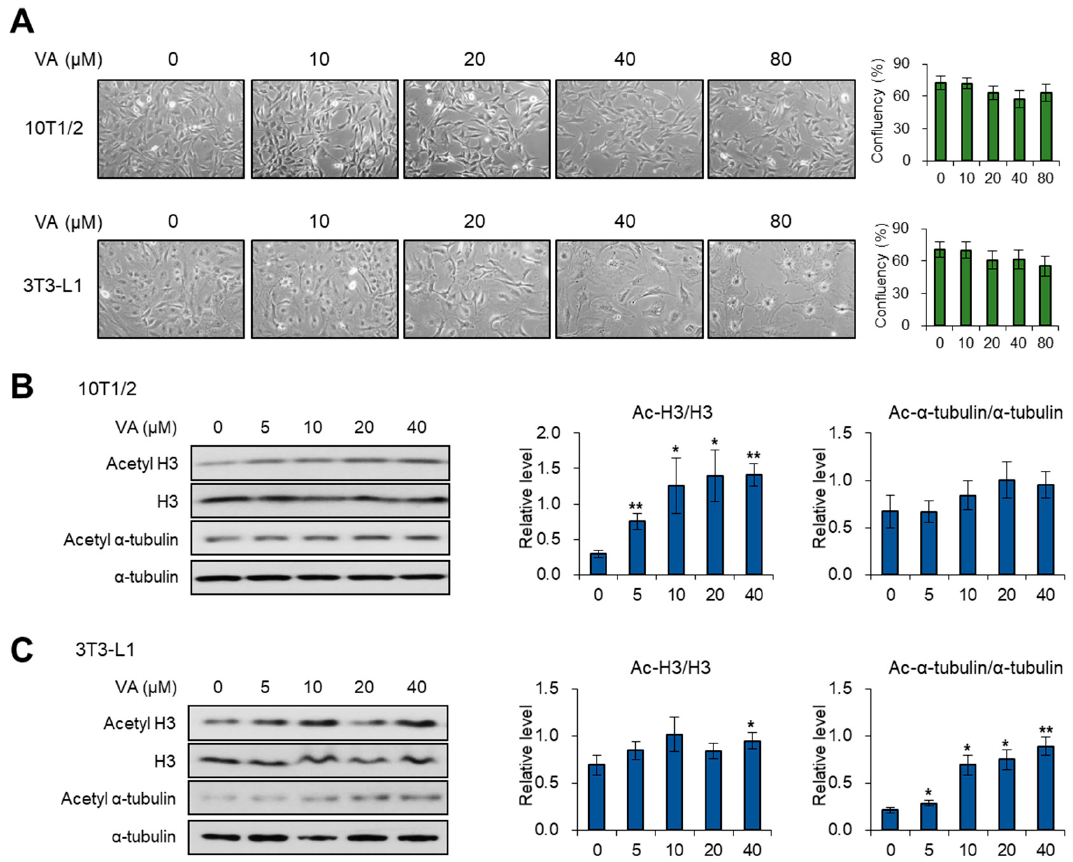
Figure 1. Vulpinic acid (VA) modulates acetylation of histone H3 and α -tubulin in 10T1 / 2 and 3T3-L1 cells. ( A ) Microscopic images (100X) of 10T1 / 2 and 3T3-L1 cells treated with vulpinic acid for 24 h at the indicated concentrations. ( B ) Immunoblot analysis of 10T1 / 2 cells treated with vulpinic acid for 24 h at the indicated concentrations. ( C ) Immunoblot analysis of 3T3-L1 cells treated with vulpinic acid for 24 h at the indicated concentrations. Data represent means ± SEM (standard e ff ort of the mean) for n = 3. * p < 0.05, ** p <